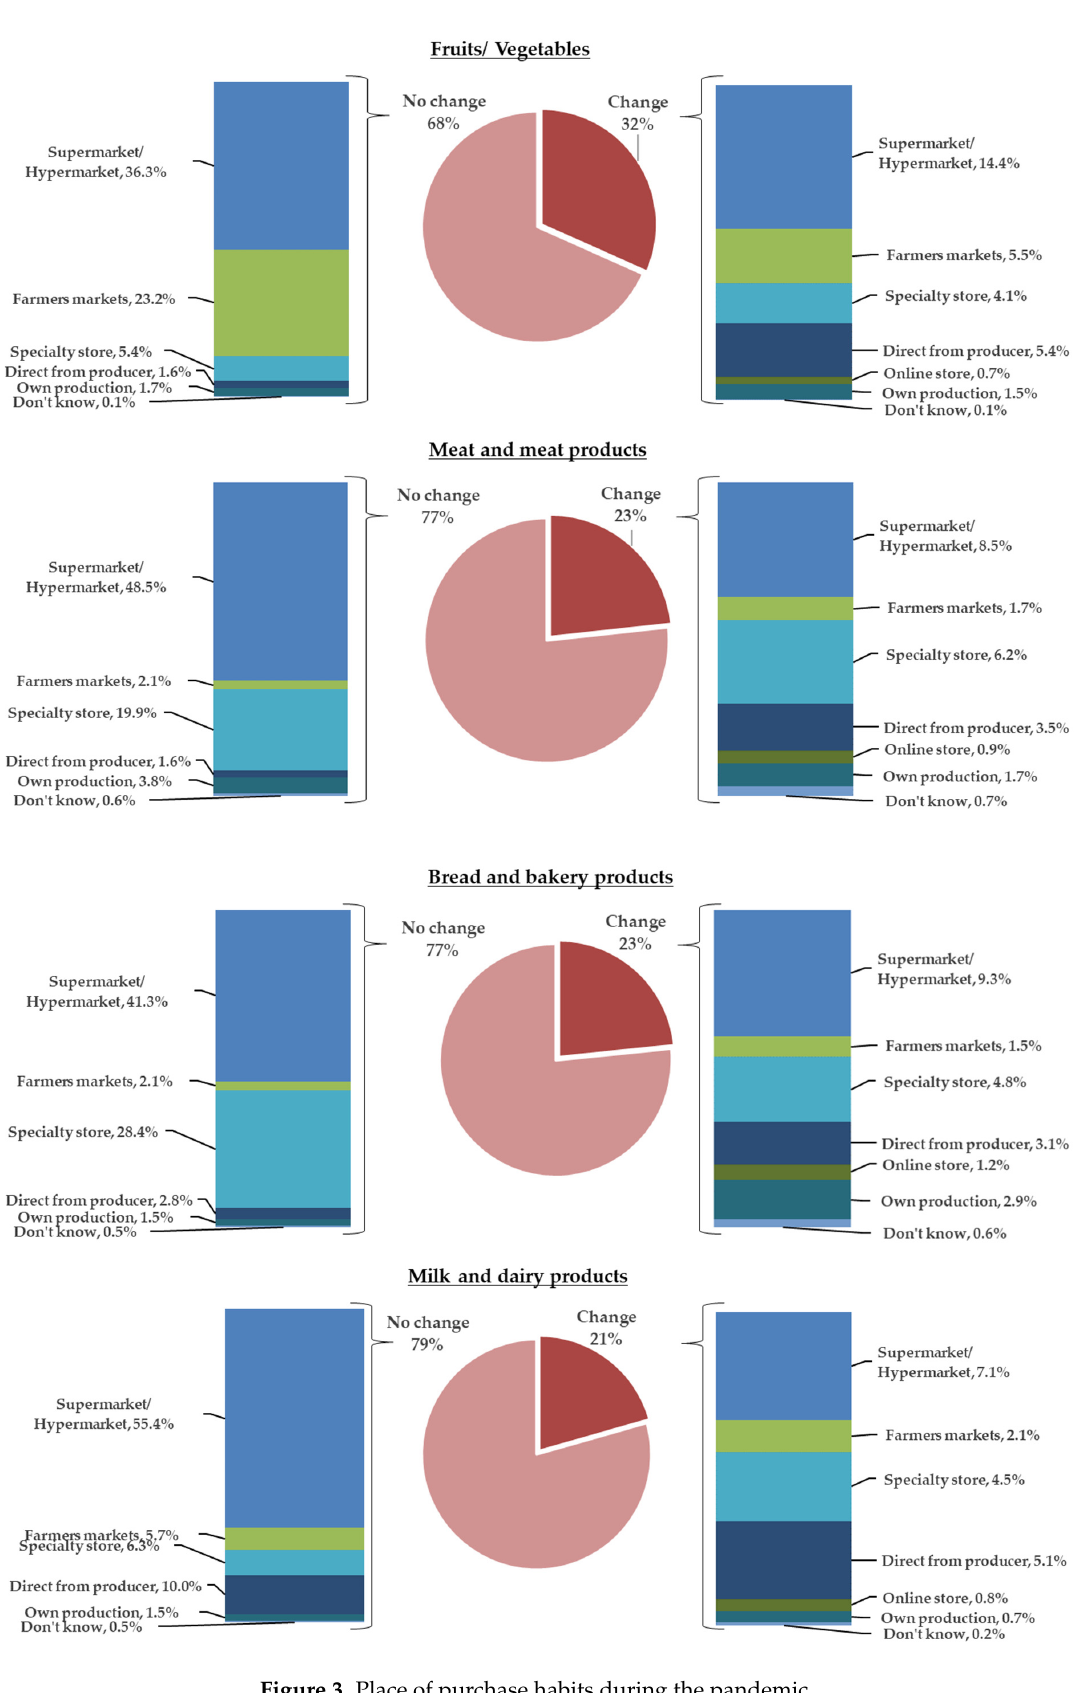
Figure 3. Place of purchase habits during the